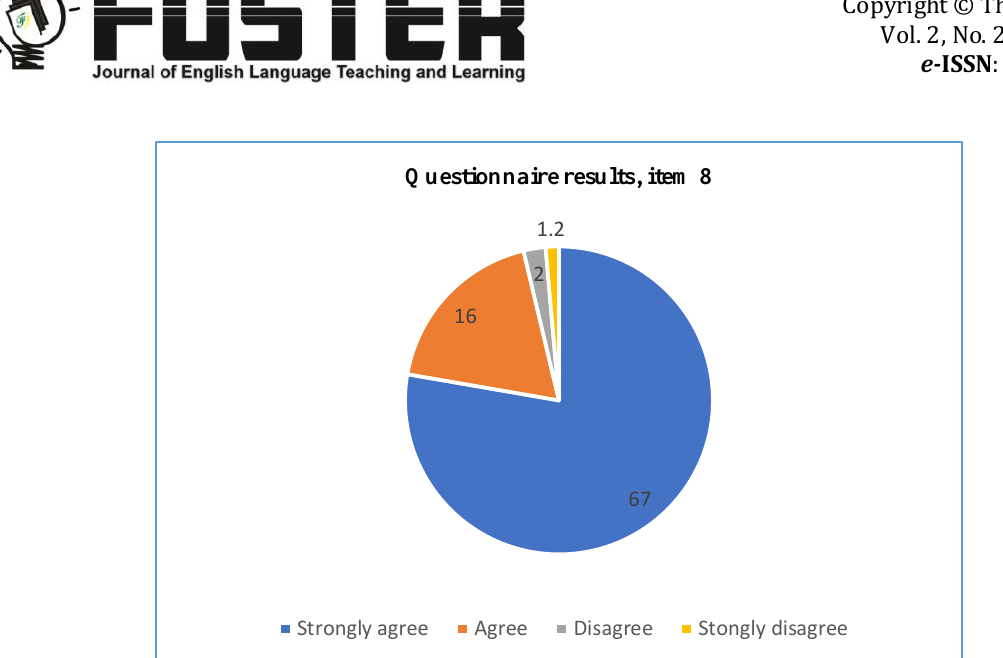
Figure 2. Teachers’ perception about self -evaluation effectiveness (questionnaire item